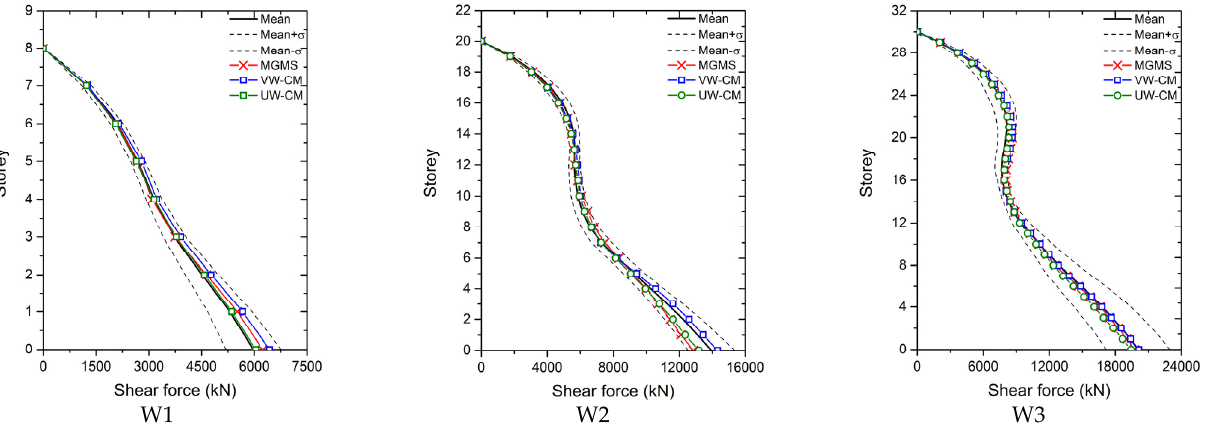
Figure 6. Comparison of the shear force of wall structures under motion Set 2.